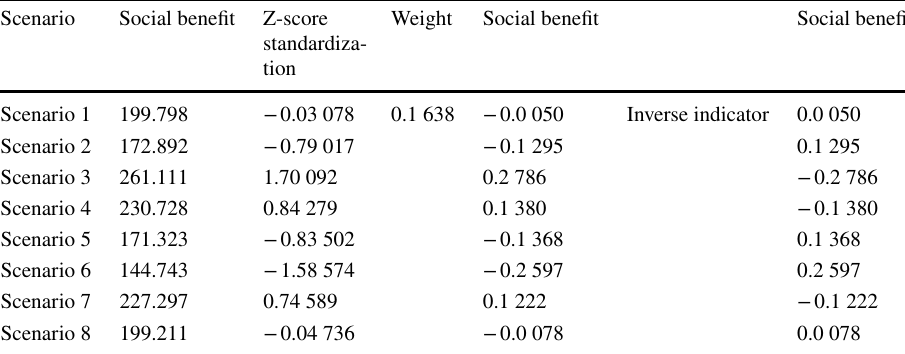
Table 2 Social benefit value of each scenario in 2035